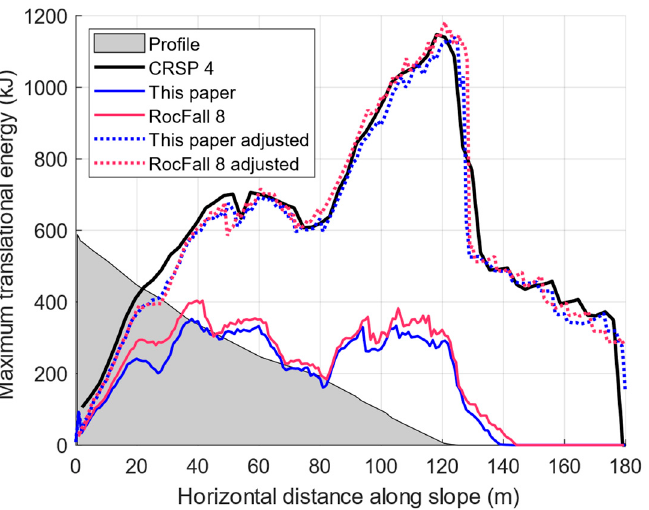
Figure 21. Distribution of the simulated maximum translational kinetic energy obtained along the Rifle rockfall test site.